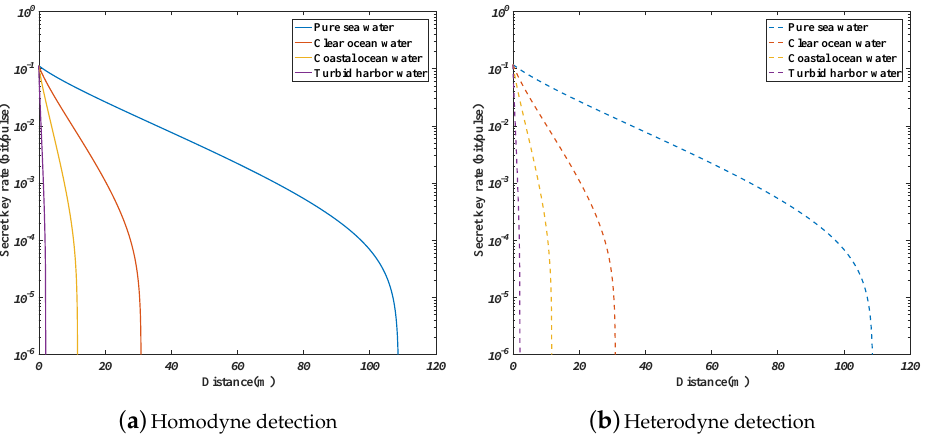
Figure 6. (Color online.) Secret key rate of the eight-state protocol for realistic reconciliation efficiency of 90% and a quantum efficiency of Bob’s detection equal to 0.6 with thermal noise v el = 0.01. V A = 0.6, ε = 0.01 (in shot-noise